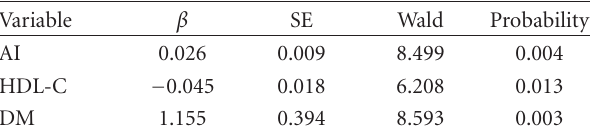
Table 4: Cox hazard stepwise regression analysis for cardiovascular